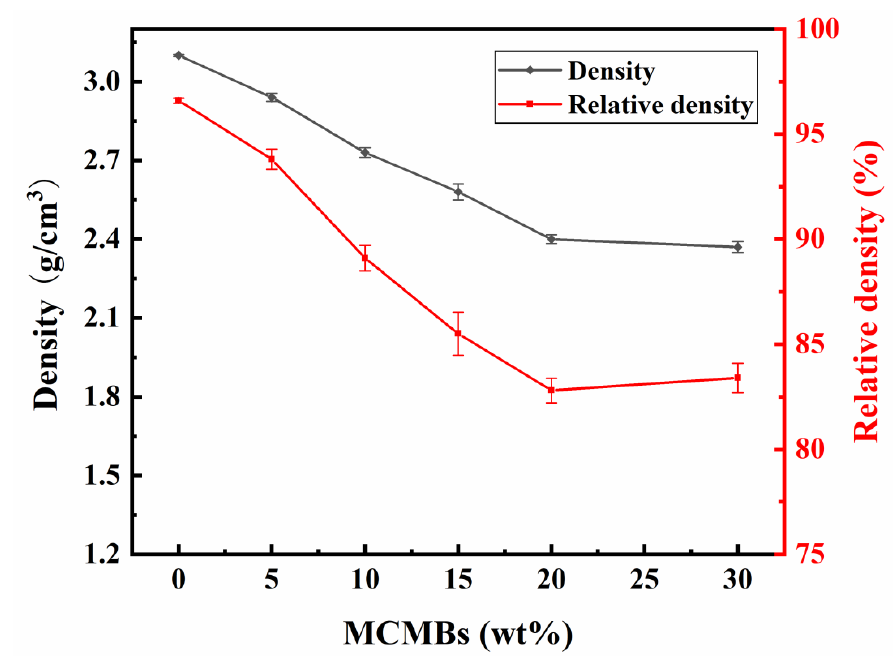
Figure 3. Density and relative density fluctuate with increasing MCMB content.